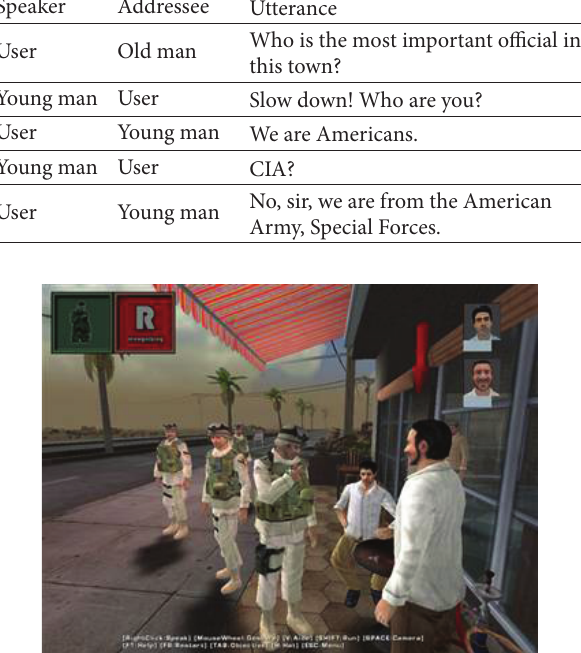
Figure 1: Tactical language training